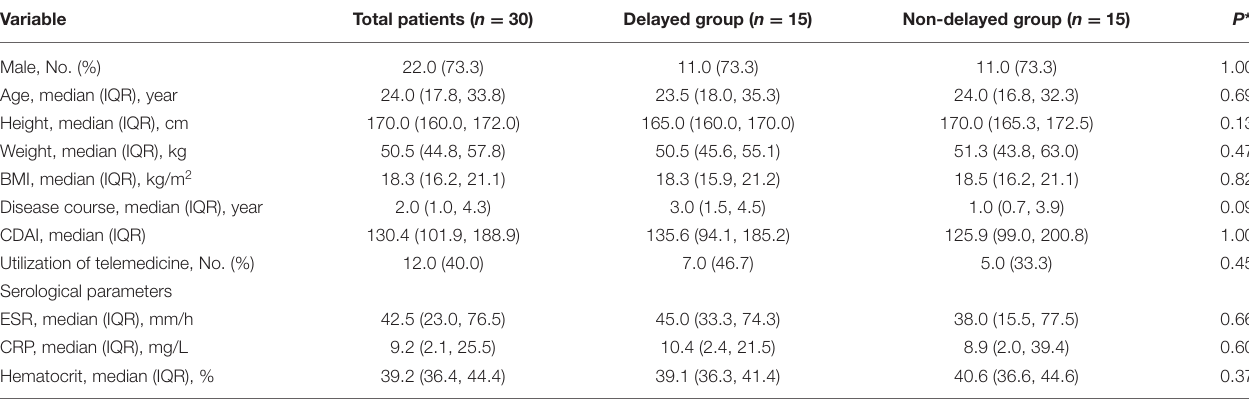
TABLE 3 | Baseline characteristic of the enrolled patients after propensity score-matched analysis.